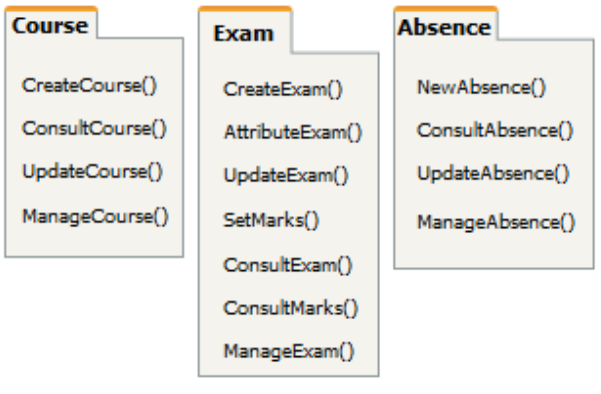
Fig. 4. Conceptual Model of the School study